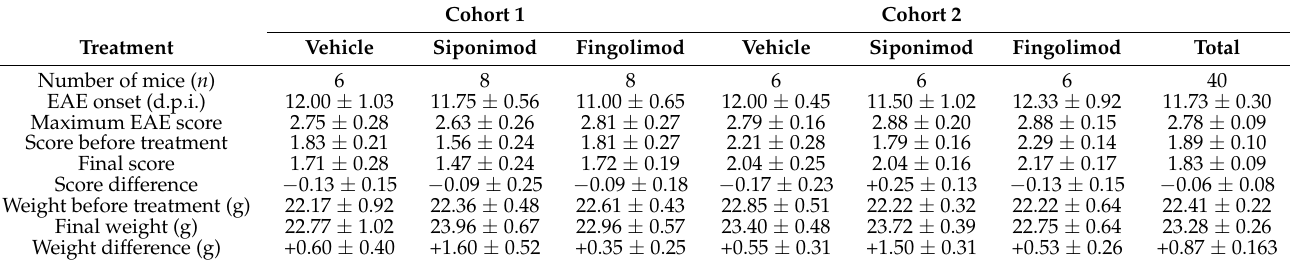
Table 1. Clinical EAE parameters in various treatment groups. Cohort 1 Cohort 2